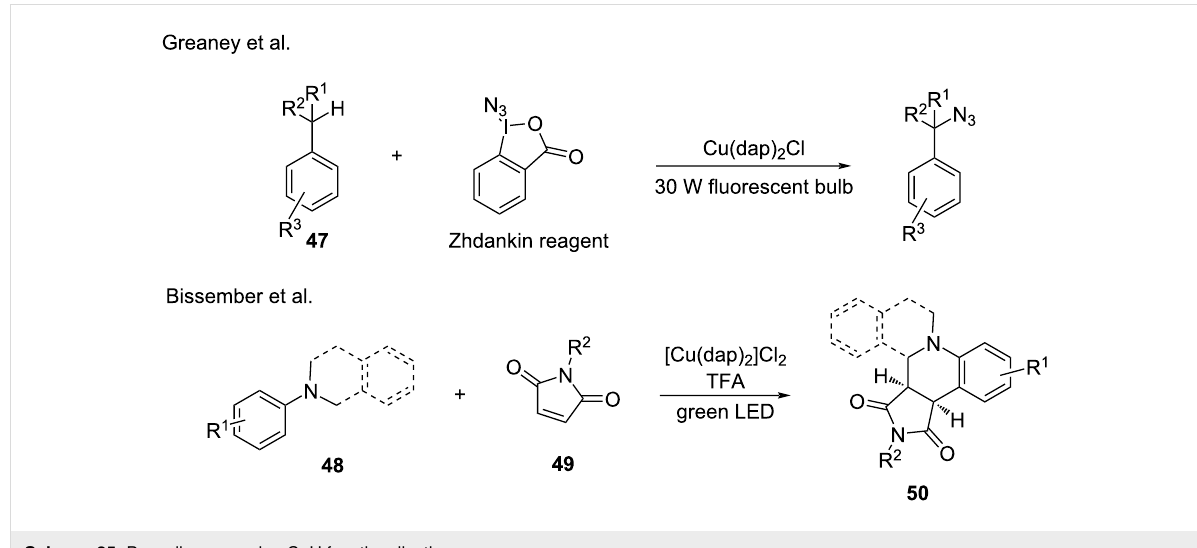
Scheme 25: Benzylic or α -amino C–H